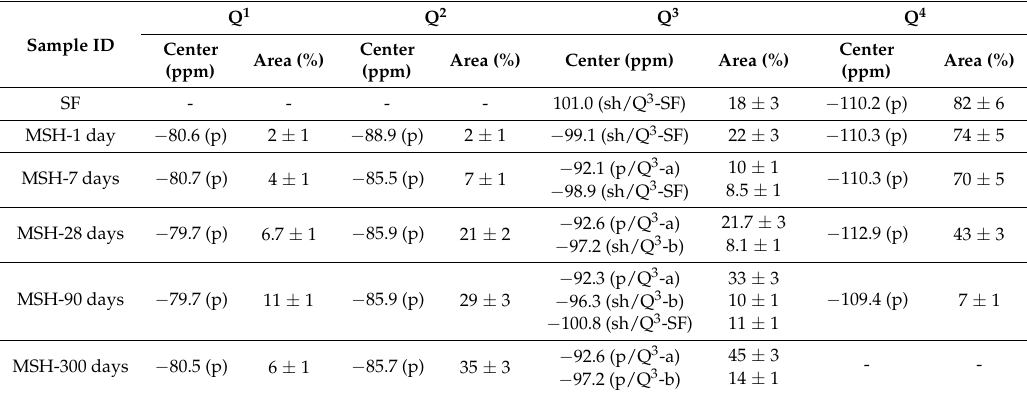
Table 4. 29 Si nuclear magnetic resonance (NMR) chemical shifts (ppm) and relative intensities (%) from de-convolution of the 29 Si MAS NMR spectra for the MSH samples *.